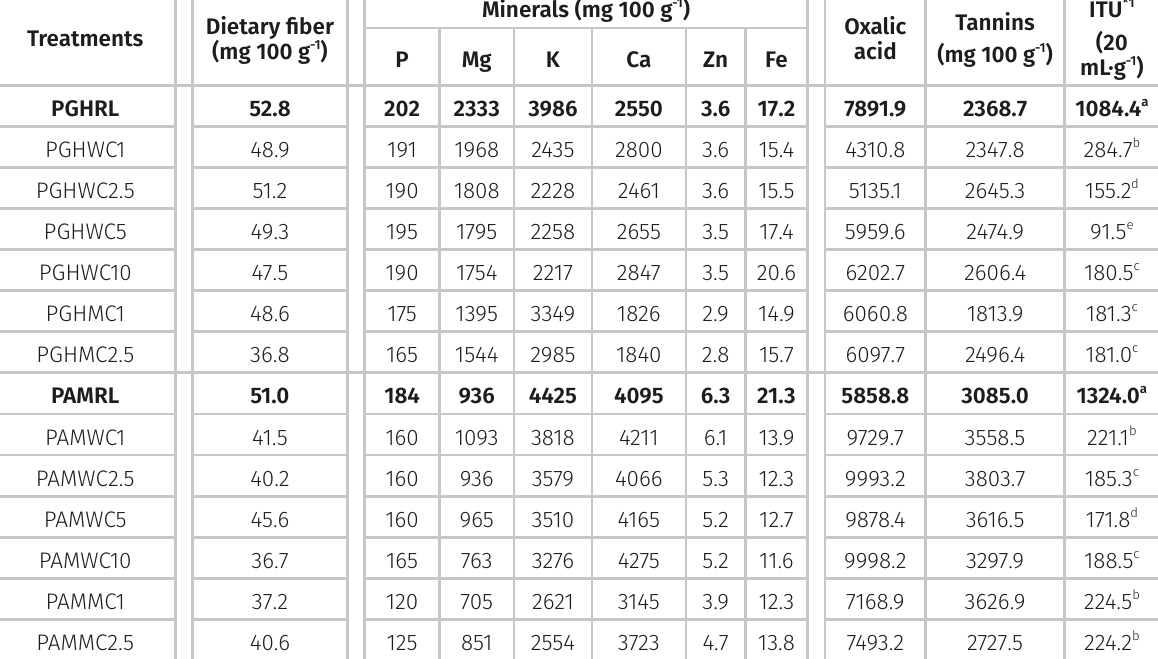
Table II. Mean values of total dietary fiber, minerals, and antinutritionals (oxalic acid, tannins, and trypsin inhibitors) in leaves of Pereskia grandifolia Haworth (PGH) and Pereskia aculeata Miller (PAM), raw and subjected to wet- and mixed-cooking processes for various